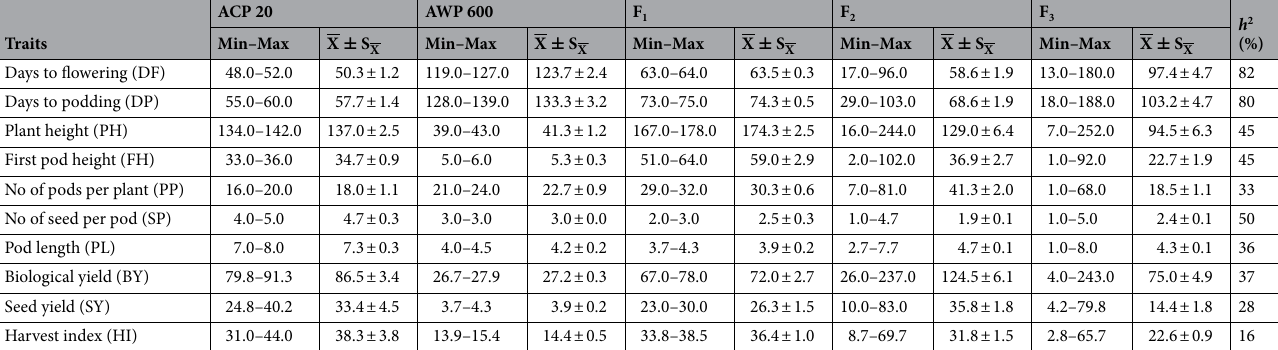
Table 3. Minimum (Min) and maximum (Max) values, means ( X ) ± standard errors ( S X ) and narrow-sense 2 heritability ( h ) for agro-morphological traits in parents and progeny derived from interspecific crosses P. sativum × P.